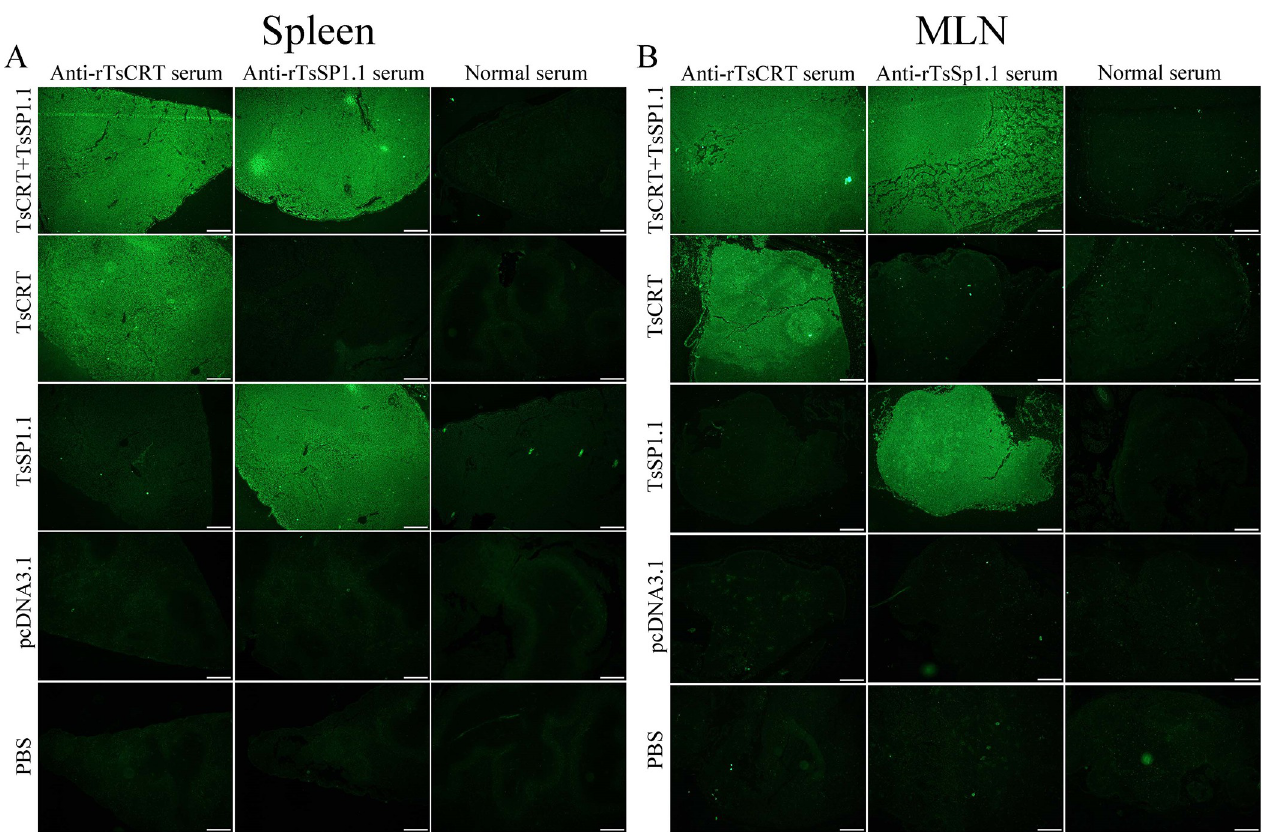
Fig 6. The in vivo expression of TsCRT+TsSP1.1, TsCRT and TsSP1.1 in spleen and MLN of immunized mice were assessed using IIFT. IIFT with anti- rTsCRT and anti-rTsSP1.1 sera showed that immunostaining was observes in vaccinated murine spleen ( A ) and MLN ( B) sections, but not in spleen and MLN sections probed using normal serum. No immunostaining in spleen and MLN sections of mice inoculated with only empty pcDNA3.1 and PBS alone was detected by immune serum. Scale bar: 200 μ